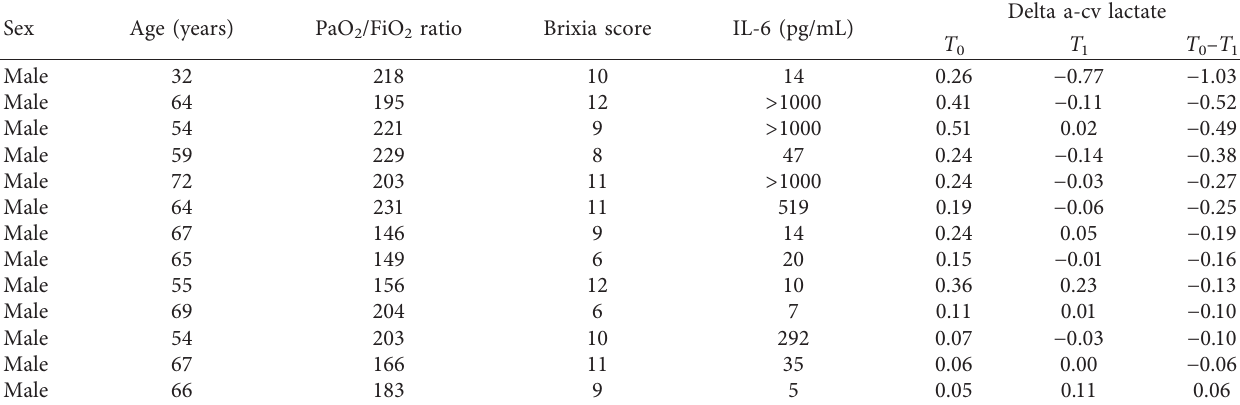
Table 3: Main characteristics and Delta a-cv lactate variation in 13 patients treated with canakinumab.